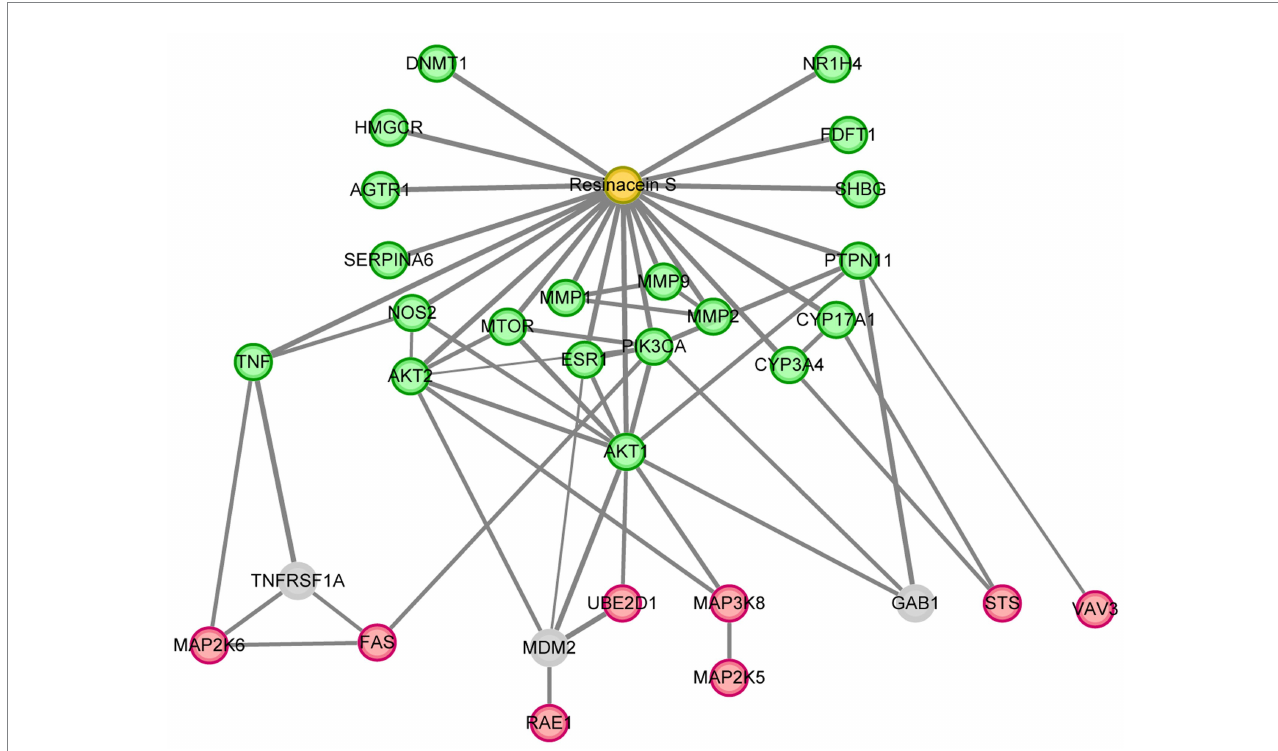
FIGURE 6 The hub proteins of Resinacein S regulated against NAFLD. The interaction relationship analysis was performed with the DEGs of Resinacein S regulated in human liver cells and the target genes of Resinacein S against NAFLD from public database. DEGs of Resinacein S regulated in human normal liver cells were shown in red circle, and the 20 target genes of Resinacein S against NAFLD from public database were shown in green. The analysis was generated by Cytoscape